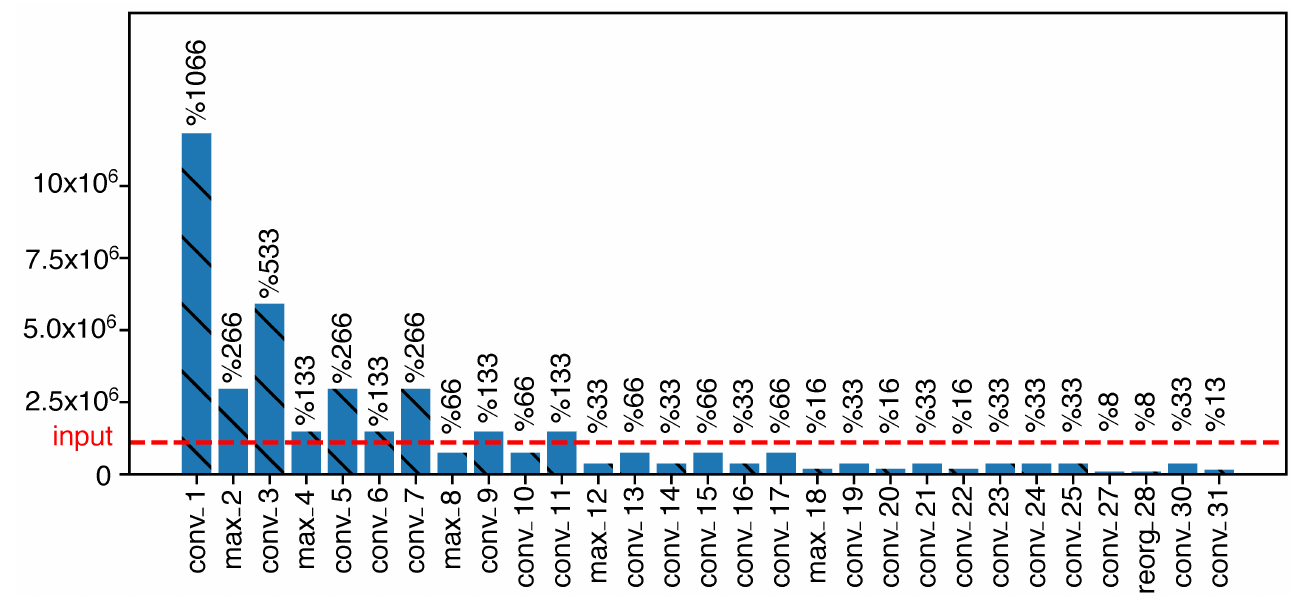
Figure 4. Output size of each layer in YOLOv2 for conv -olutional and max -pooling layers [29].